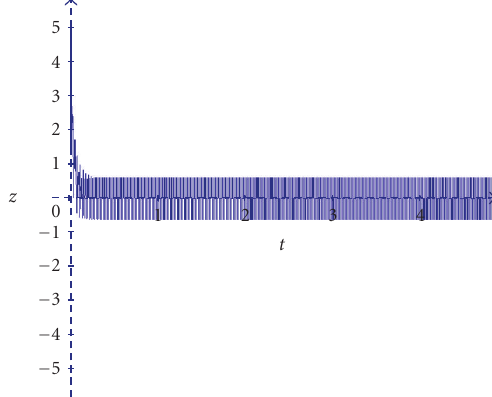
Figure 6.15 . Bounded solution of (5.2) in the point Q (288 . 65,170), a 0 = 5.